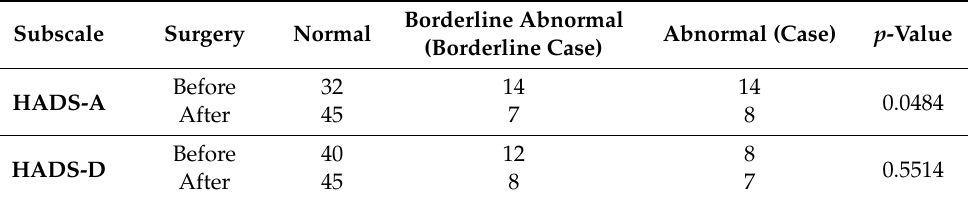
Table 3. HADS subscales for women before and 12 months after the surgery between groups were marked by different letters.